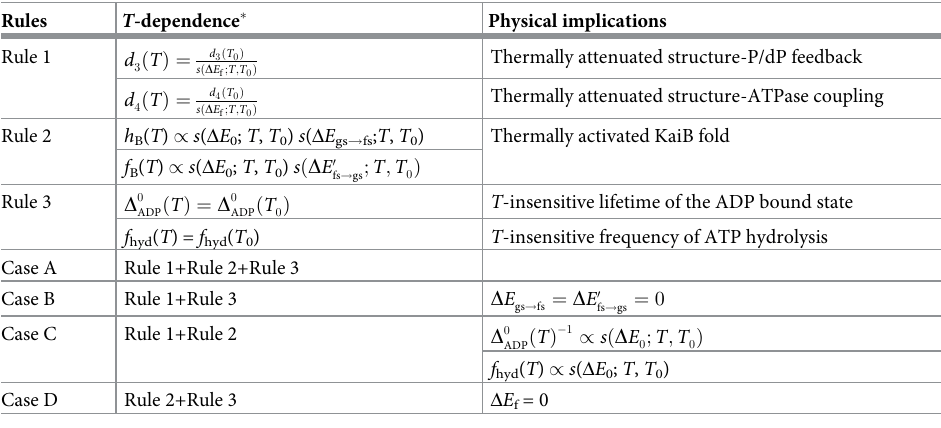
Table 1. Temperature dependence/independence of specific